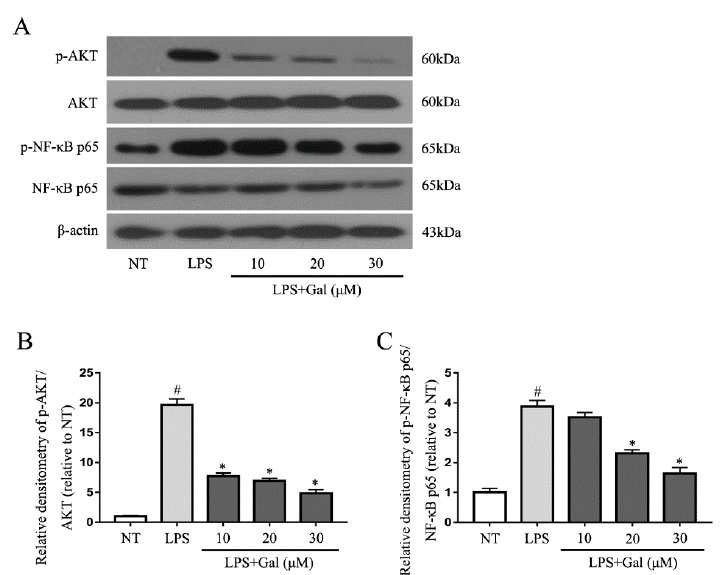
Figure 6. Galangin inhibited the phosphorylation of NF- κ B p65 and AKT. ( A ) Western blot analysis for the phosphorylation of NF- κ B p65 and AKT ( n = 3). Cells were pretreated with various concentrations of galangin (10, 20, and 30 μ M) for 1 h, followed by stimulation with LPS for 1 h, then collected. Western blot analysis was performed using antibodies against phospho- or total forms of AKT and NF- κ B p65; ( B , C ) The relative densitometry of p-NF- κ B p65 and p-AKT (relative to normal). Data are shown as means ± SD. # p < 0.05 compared to NT, * p < 0.05 compared to the LPS group.